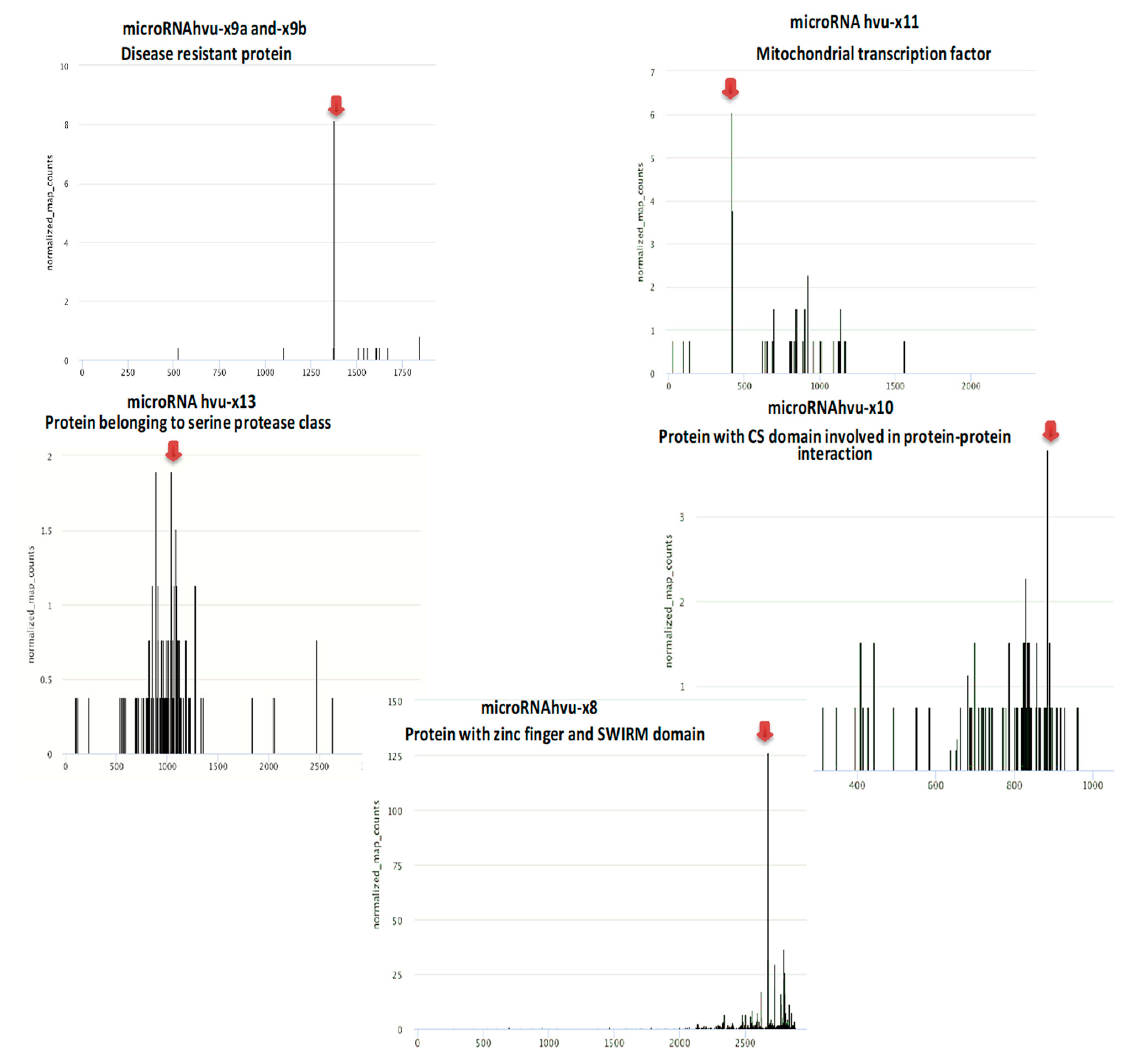
Figure 6. Target plots (T plots) for target mRNAs of novel barley microRNAs. The x-axis on the graphs represents the length of the targeted mRNA, y-axis shows normalized number of reads. Names of novel barley miRNAs and information about their targets are provided above the graphs. Red arrows indicate the position of the predicted cleavage site in particular mRNA.